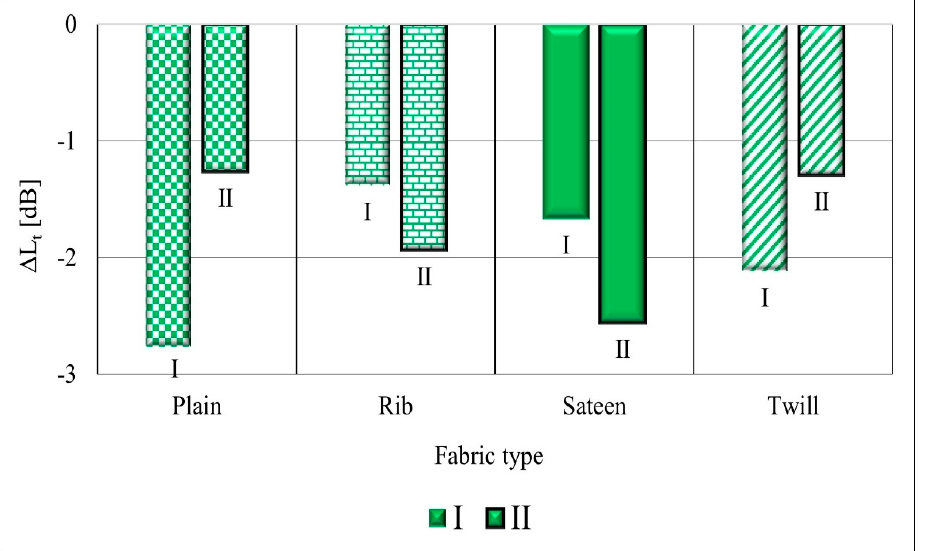
Figure 9. Comparison of total sound pressure level drop between fabrics formed from; textured yarn (I) and textured yarn (II).